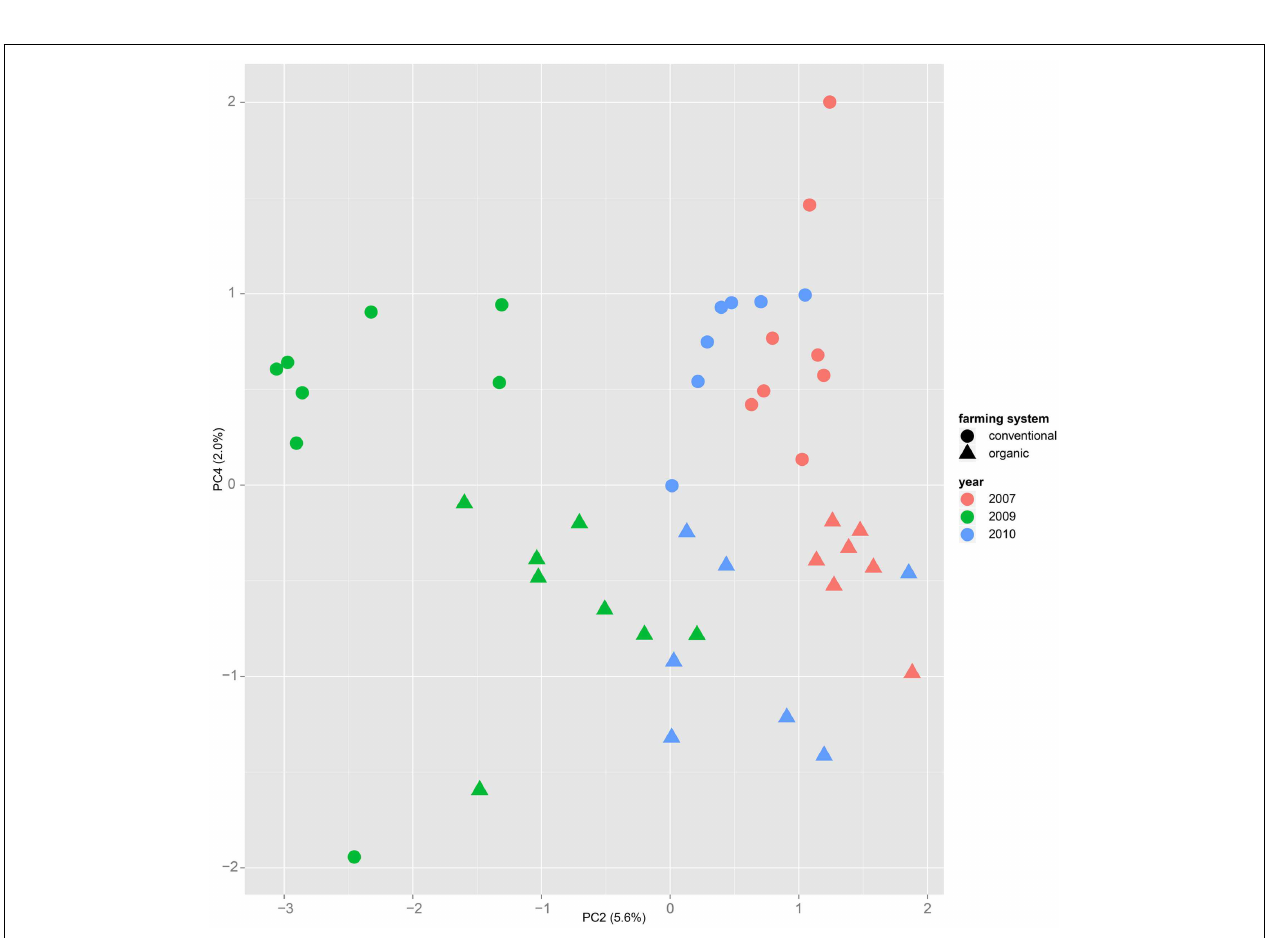
FIGURE 4 | Plotting samples from one cultivar (here “Runal”) along the principal components two and four show that a separation by farming system might be possible, even though the main variance is caused by the factor year